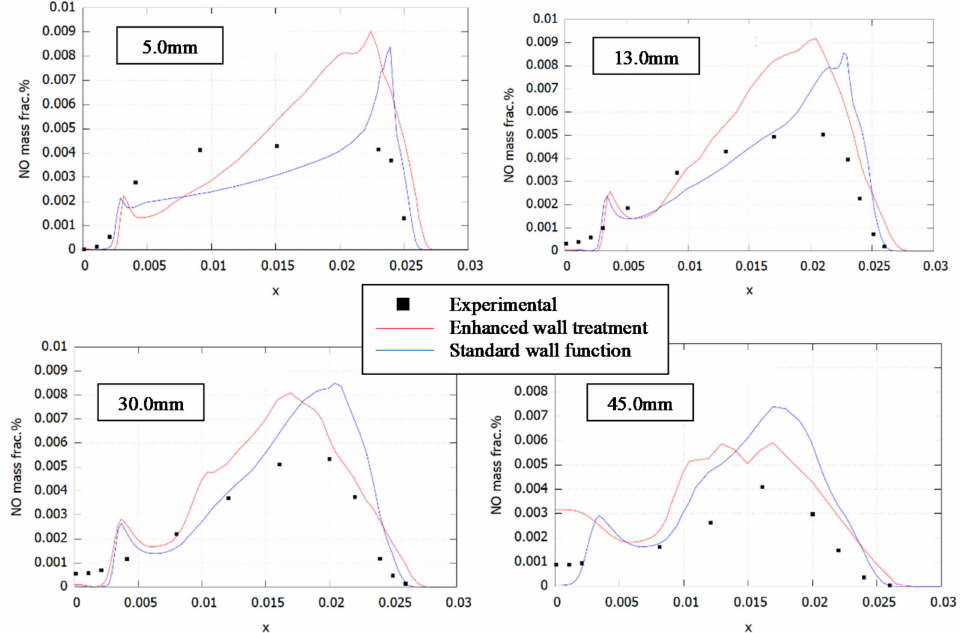
Figure 15. NO mass fraction profiles at increasing axial distances. FGM/CRECK. Complete experi- mental data available at reference